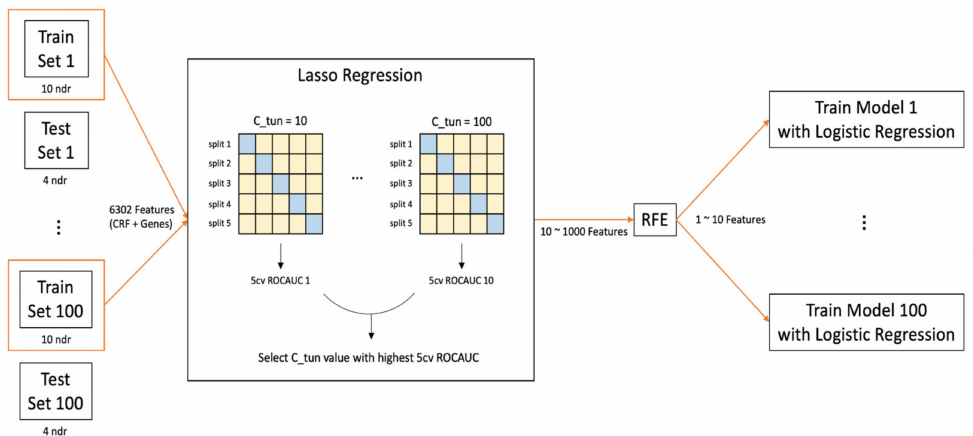
Figure 2. The overall model training scheme. The dataset was split into training and test sets in an 8:2 ratio. This random split was repeated 100 times. For each split, the model training involving Least Absolute Shrinkage and Selection Operator (LASSO) regression, and recursive feature elimination (RFE) was performed. In the LASSO regression, the C parameter was scanned from 10 to 100 in multiples of 10 for the highest 5-fold cross-validation (5-CV) area under the receiver operating characteristic curve (AUC-ROC) value. For the best C parameter, typically 10 to 1000 features survived. Among these features, a fixed number, ranging from 1 to 10, of features was selected through RFE. For a given number of the selected features, 100 different models were developed due to the 100 random data splits. The model performance was evaluated with the test set using logistic regression of the selected feature(s). For 5-CV, the training and test sets are shown in light yellow and blue,